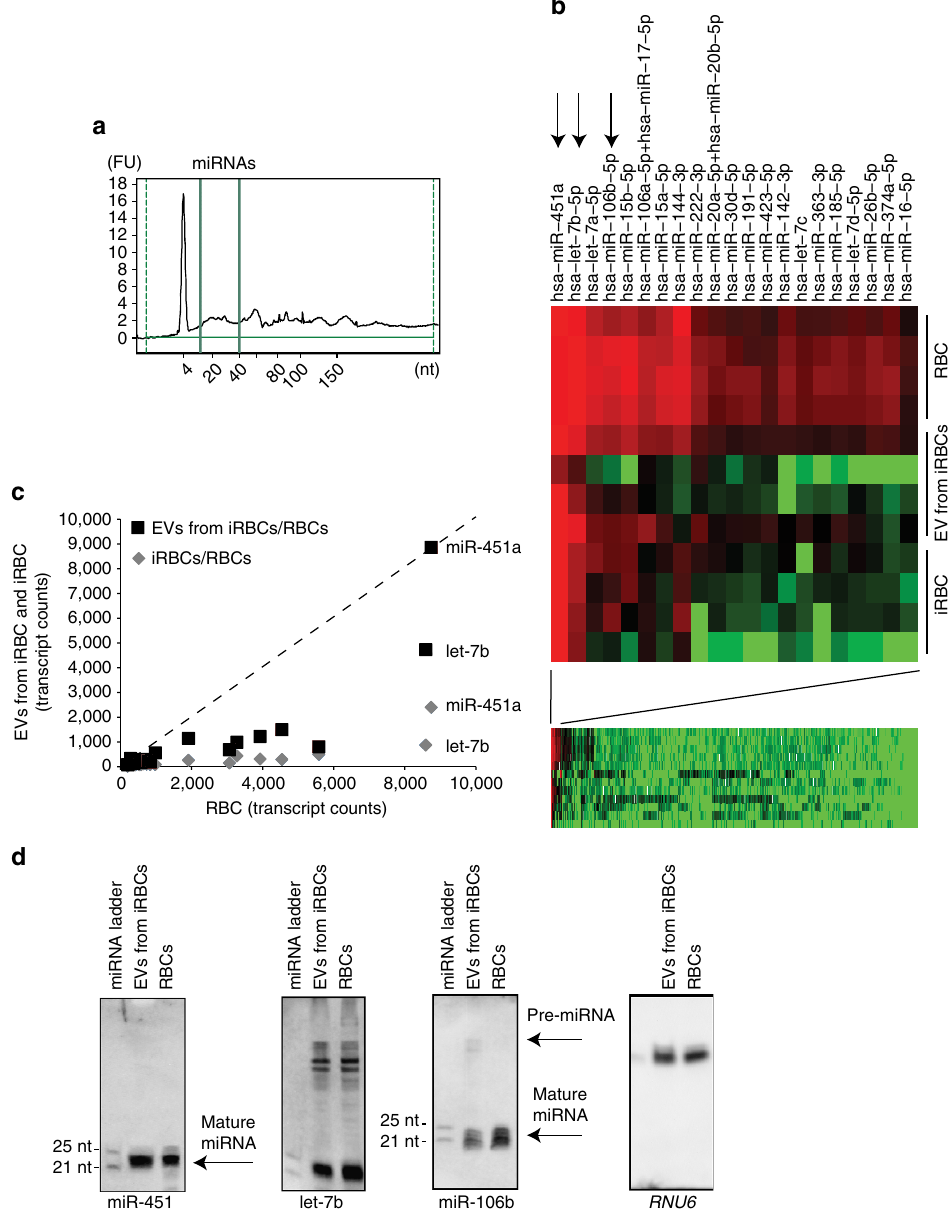
Figure 1 | Detection of human miRNA species in EVs. ( a ) EVs derived from iRBCs contain small RNAs. RNA samples were prepared from EVs and analysed by Agilent Bioanalyzer Small RNA Chip. Small RNA species of up to 150 nucleotides are detected, including species between 20 to 25 nucleotides (range marked by green lines). FU, fluorescence units. ( b ) miRNA profiling of iRBCs, EVs from iRBCs and RBCs by nanostring. miRNA preparations from four experiments were analysed using a Nanostring miRNA array containing 800 human miRNA species. Normalized data from the entire array are shown in the left panel. Twenty-one miRNAs are expressed in RBCs, of which a subset is also present in iRBCs and EVs from iRBCs (right). These are (in order of expression levels) miR-451a, let-7b, let-7a, miR-106b and miR-15b. Those that are further characterized in this study are marked with black arrows. ( c ) Differential abundance of miRNA species in RBCs, EVs from iRBCs and RBCs. The normalized Nanostring data from b are represented as correlations between the mean expression across four experiments of RBC and the mean expression of either iRBCs (black boxes) or EVs from iRBCs (grey diamonds). miR-451a and let-7b show similar abundance across all three populations, while the other miRNA species are greatly reduced in iRBCs and EVs from iRBCs. ( d ) Detection of miRNAs by northern blot. RNA samples from RBCs and EVs from iRBCs are hybridized with probes specific for miR-451a, let-7b and miR-106b. The northern blot shows specific bands at the expected size of 22 nucleotides for miR-451a and let-7b, and of 21 nucleotides for miR-106b. In addition unprocessed Pre-miRNA species at the expected size of 70 nucleotides are detectable for let-7b and miR-106b. Shown is also a blot for U6 small nuclear RNA ( RNU6 ) as a control for RBC-derived non-miRNA RNA species 23 . Samples were normalized using equal RNA